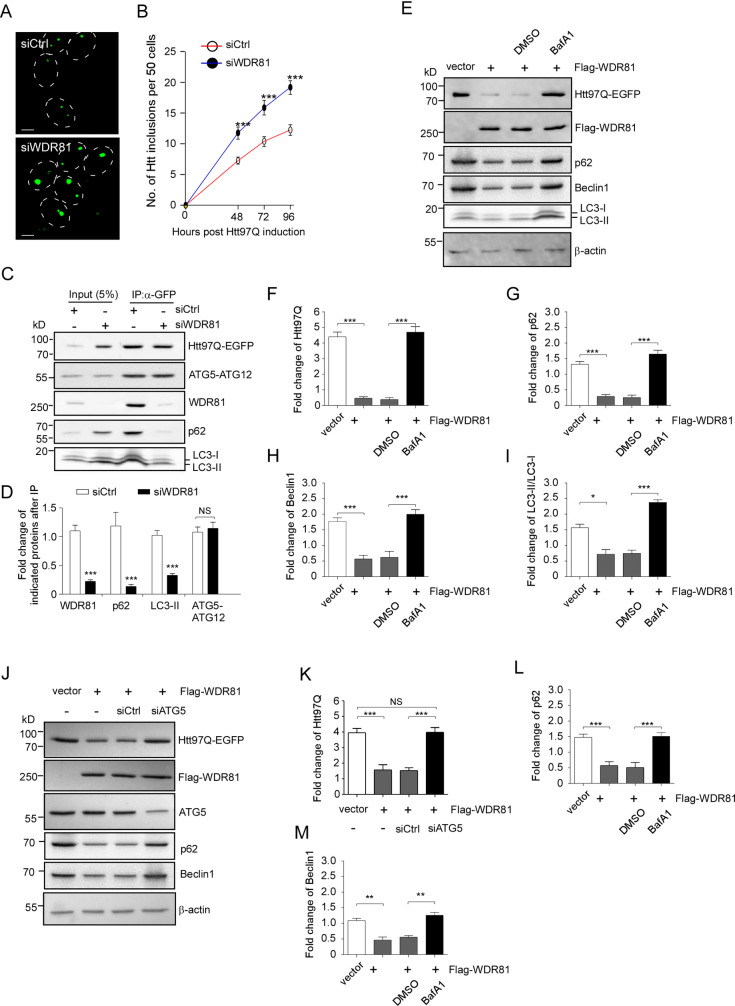
WDR81 promotes the autophagic clearance of Htt97Q-EGFP aggregates.(A and B) Number of Htt97Q-EGFP inclusions without (siCtrl) or with knockdown of WDR81 (siWDR81) in HeLa cells stably expressing Htt97Q-EGFP. 12 h after the second siRNA transfection, DOX was administrated into medium to induce Htt97Q-EGFP expression. 200 cells in 10 fields of each sample were measured. White dotted lines are the outlines of cells. (C and D) Knockdown of WDR81 reduces association between Htt97Q-EGFP and endogenous p62 and LC3-II, but not covalent bound ATG5-ATG12. Representative images of immunoprecipitation of Htt97Q-EGFP and indicated proteins were shown in the upper panel. Statistical analysis of the association between Htt97Q-EGFP and indicated proteins was shown in the bottom panel. (E-I) WDR81-mediated clearance of Htt97Q-EGFP was dependent on lysosome activity. DOX was added to induce Htt97Q-EGFP expression. 12 h later, Flag-WDR81 (1.5 μg) was transfected into cells. After 12 h, v-ATPase inhibitor, BafA1 (0.4 μM) was added into medium to block capacity of lysosomal degradation. Statistical analysis of clearance of Htt97Q-EGFP and autophagic proteins was shown in the bottom panels. (J-M) WDR81-mediated clearance of Htt97Q-EGFP was dependent on ATG5-mediated autophagy. HeLa cells stably expressing Htt97Q-EGFP were transfected twice at an interval of 24 h without or with siATG5. 12 h after the second siRNA transfection, DOX was administrated into medium to induce Htt97Q-EGFP expression. 12 h later, Flag-WDR81 (1.5 μg) was transfected into cells to promote clearance of Htt97Q-EGFP. Statistical analysis of clearance of Htt97Q-EGFP and autophagic proteins was shown in the right panels. Scale bars represent 10 μm in all panels. For quantifications, means±SEM were derived from three independent experiments and analyzed using ANOVA. * P <0.05. ** P <0.01. *** P <0.001. NS, not significant.